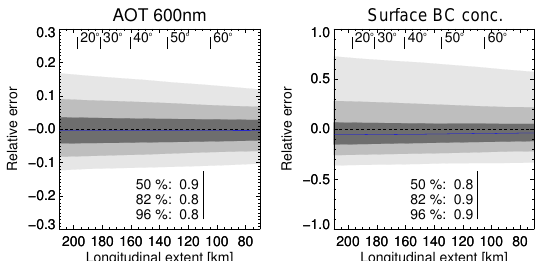
Figure 12. Relative spatial sampling errors (monthly data) as a function of longitudinal extent of the grid box (due to latitude). Near the top horizontal axis, latitudes are given. Near the bottom horizon- tal axis, the ratios of (cid:49)q 25 ,(cid:49)q 82 and (cid:49)q 96 at two different longitu- dinal extents (110 over 210km) are given. Results from WRF-Chem MADE over W. Europe. Further explanation in Sect.